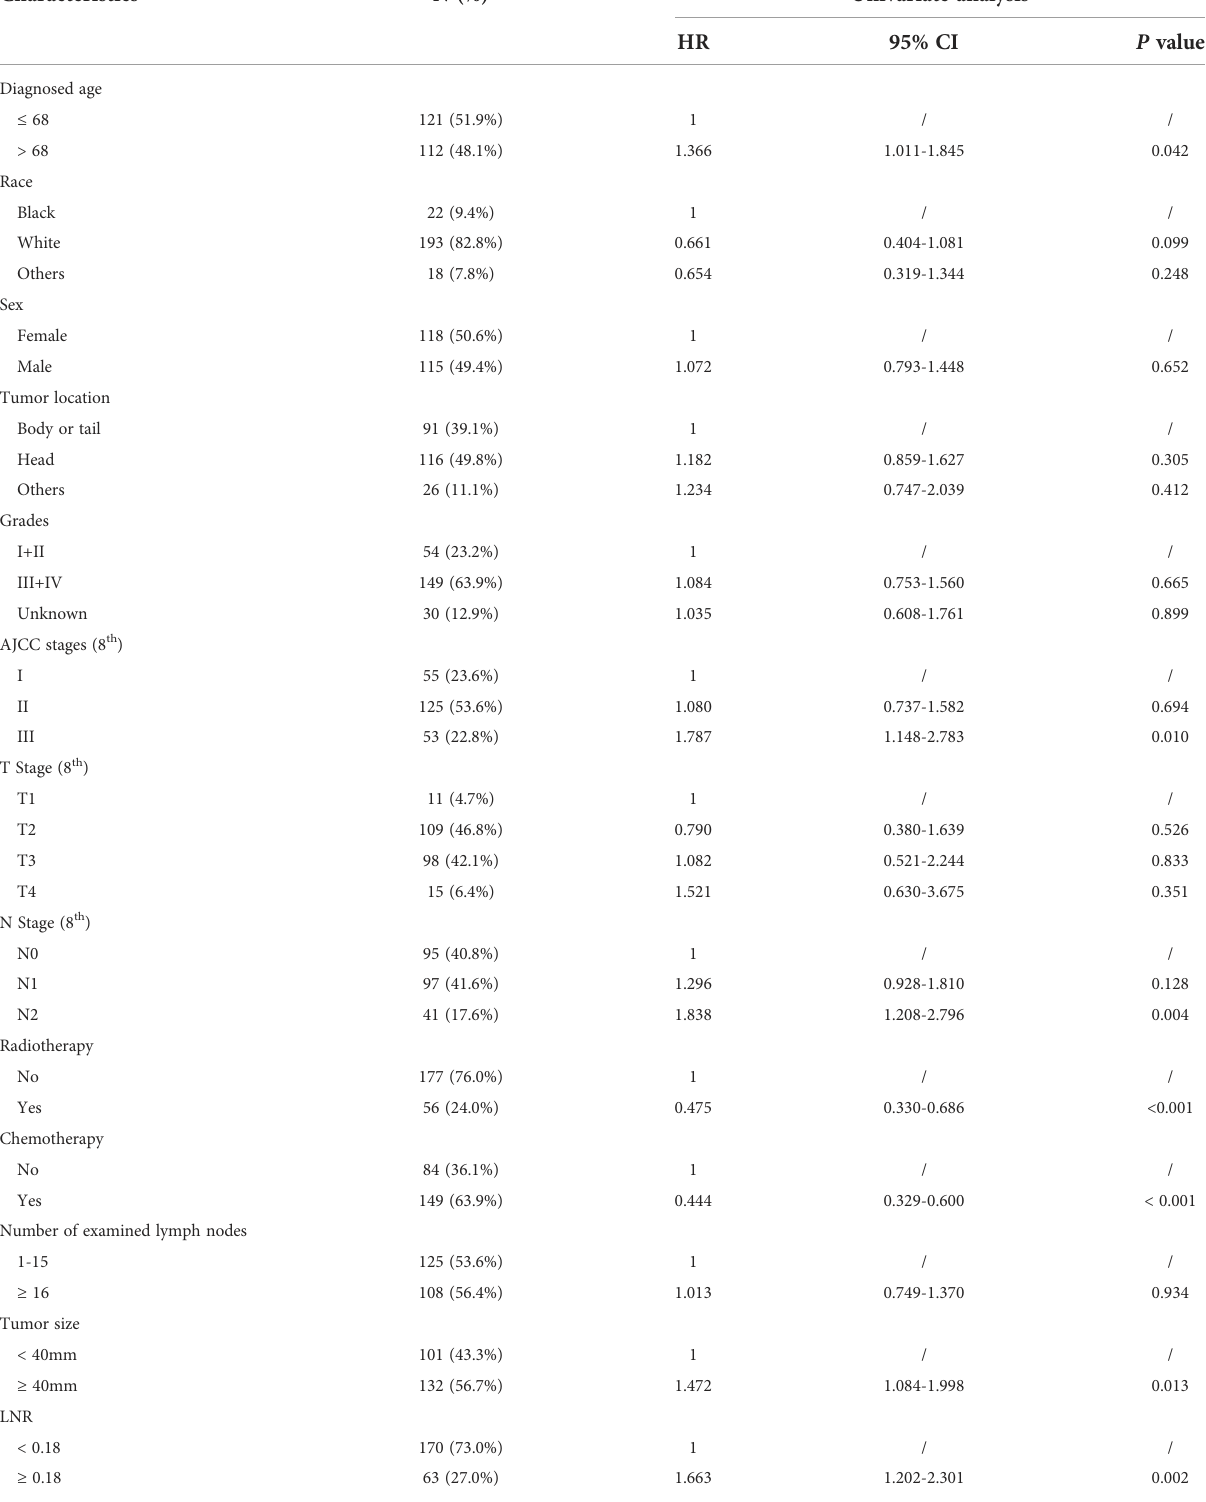
TABLE 3 Univariate analysis of clinical characteristics in ASCP